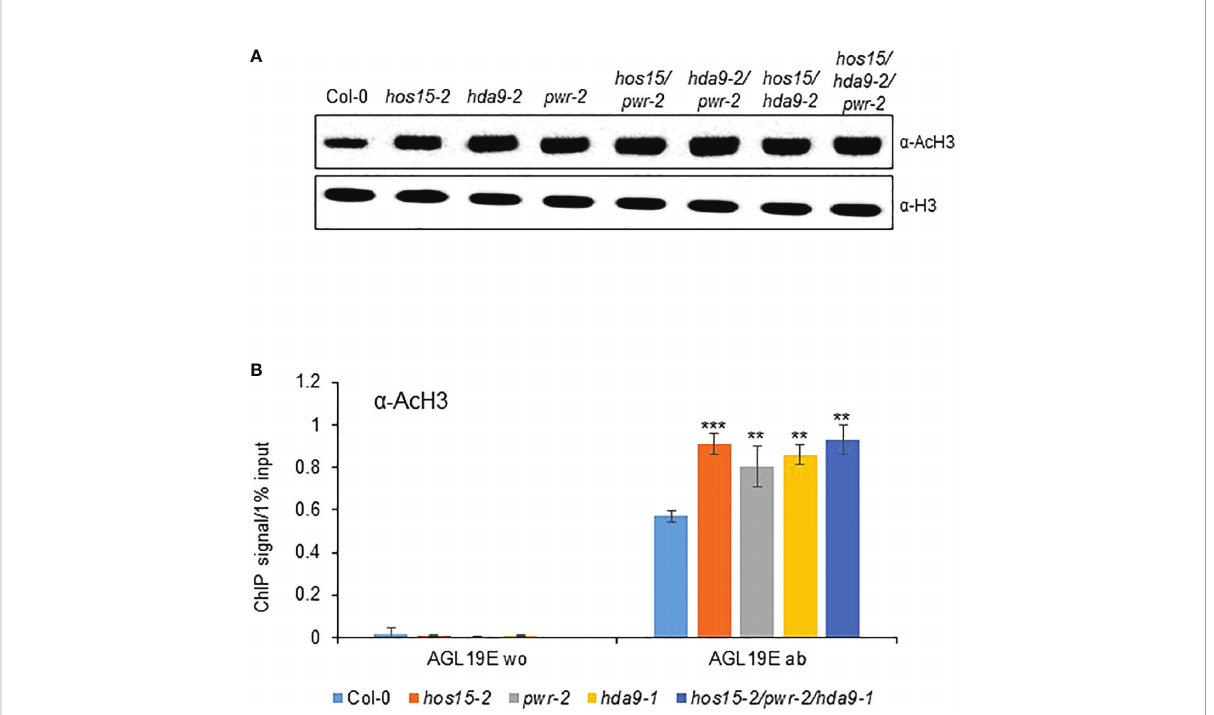
FIGURE 5 Regulation of AGL19 histone acetylation by PWR-HOS15-HDA9 complex. (A) Total proteins were extracted from two-week-old Col-0, hos15-2 , hda9 , pwr , as well as double and triple mutant plants and immunoblotted with anti-AcH3 antibody. Antibodies against histone H3 were used as the loading control. (B) Chromatin complexes from Col-0, hos15, pwr-2, hda9-1 , and hos15-2 pwr-2 hda9-1 triple mutant plants were immunoprecipitated with anti-AcH3 ( ab ). A control reaction was processed in parallel with rabbit IgG only ( w/o ). ChIP and input-DNA samples were quanti fi ed by real-time qPCR using primers speci fi c to the different regions (A – E) of the AGL19 promoter region. Data represent means ± SD from three biological replicates with three technical repeats each (n = 3). Signi fi cant difference was determined by a Student ’ s t-test (**p<0.01,